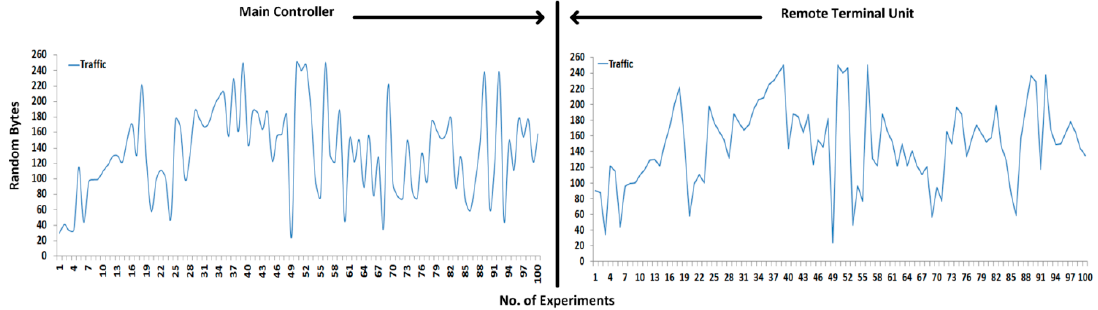
Figure 10. Traffic: ( left ): Main Controller; ( right ) Remote Terminal Unit.